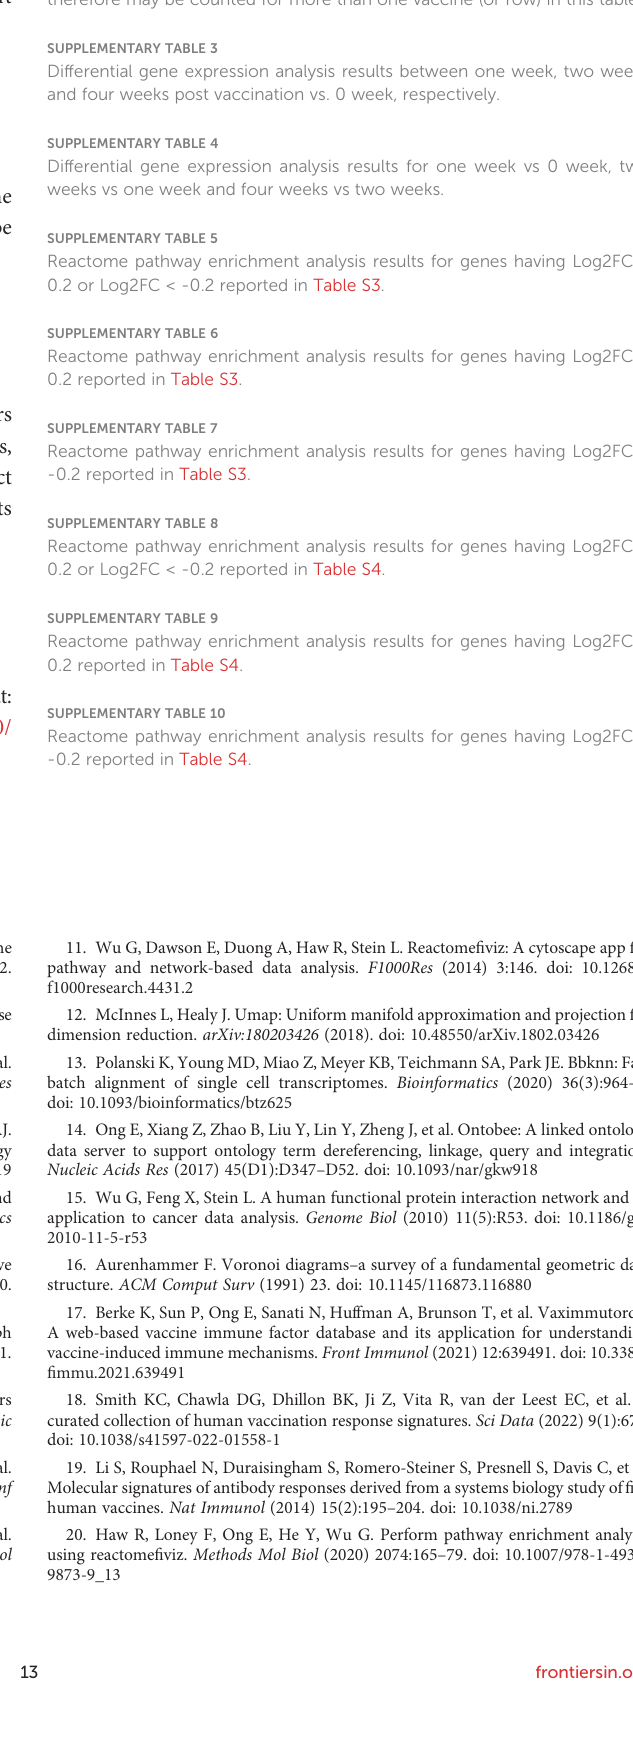
SUPPLEMENTARY TABLE 1 GSE gene expression annotation results after batch analysis.